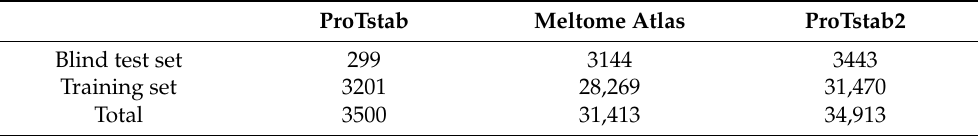
Table 2. Division of data sets for method training and testing.